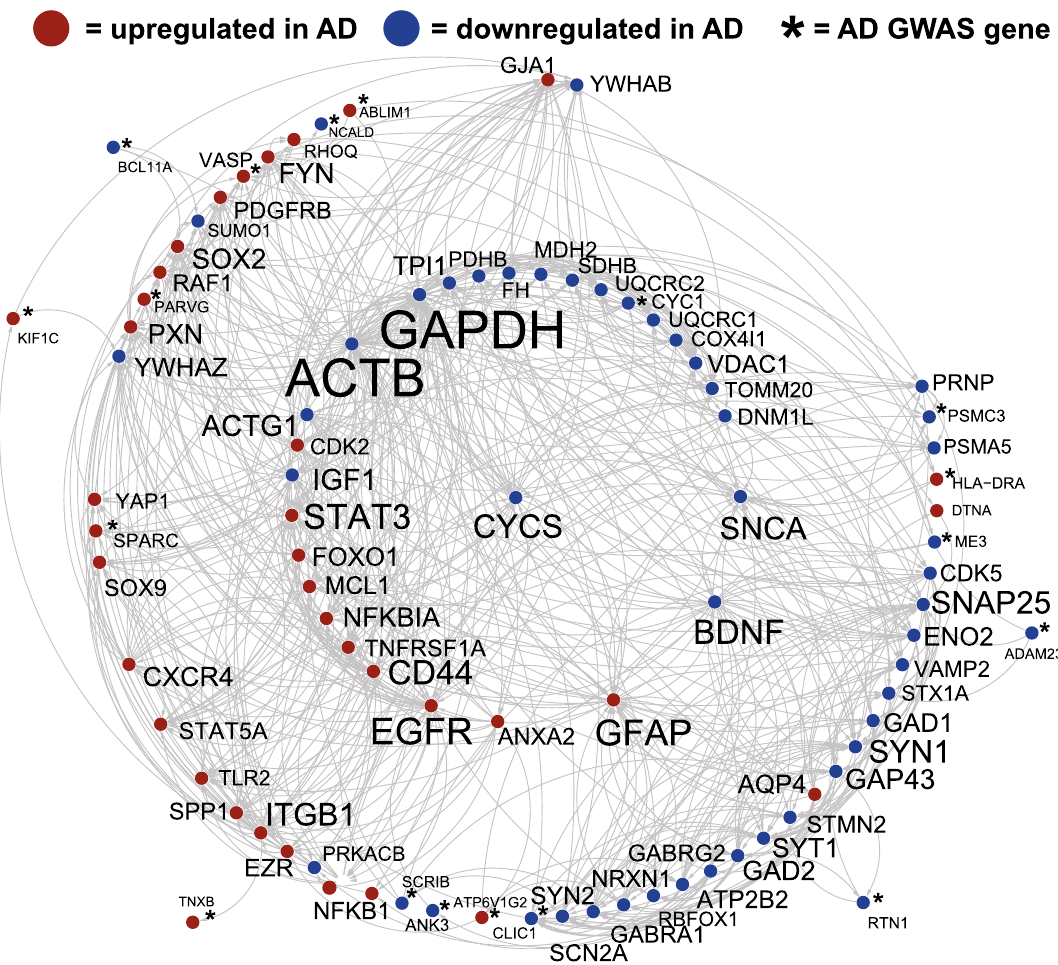
Figure 1. Top connected genes in AD portrait. Genes with the highest levels of protein–protein interaction (determined via STRING 15 ) from the top 1000 dysregulated genes in AD portrait are plotted in Cystoscape 109 . Interactions are highlighted by lines. AD upregulated genes are shown in red and AD downregulated genes are show in blue. Increased size of font for gene symbol reflects higher number of connections between genes. GAPDH and ACTB were the two genes with the most connections. Also plotted are a subset of AD portrait genes also identified in a recent GWAS analysis of AD (shown with an asterisk). Steps for identifying top interacting genes are provided in the “Methods”